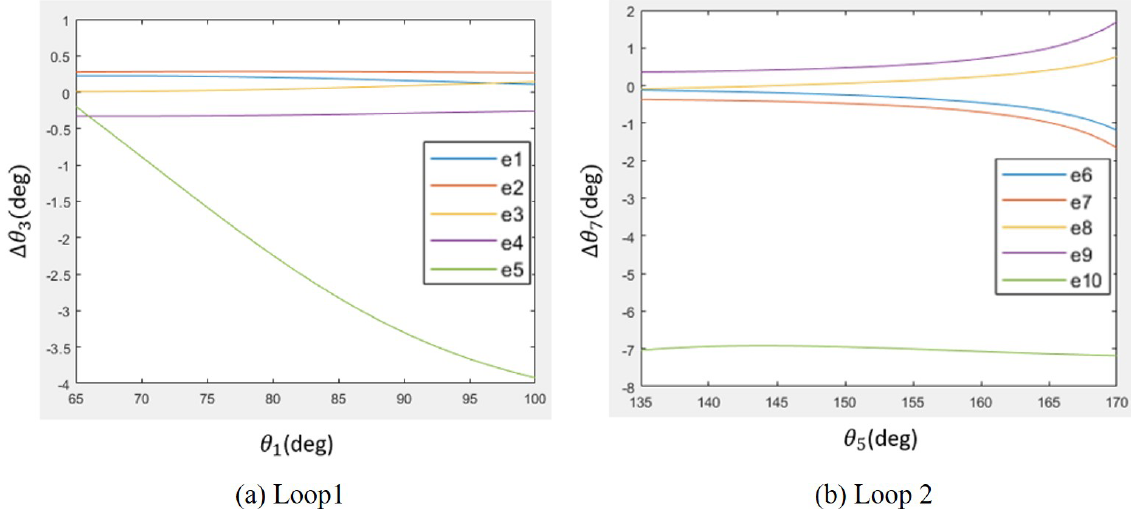
Figure 8. Output angle errors analysis.